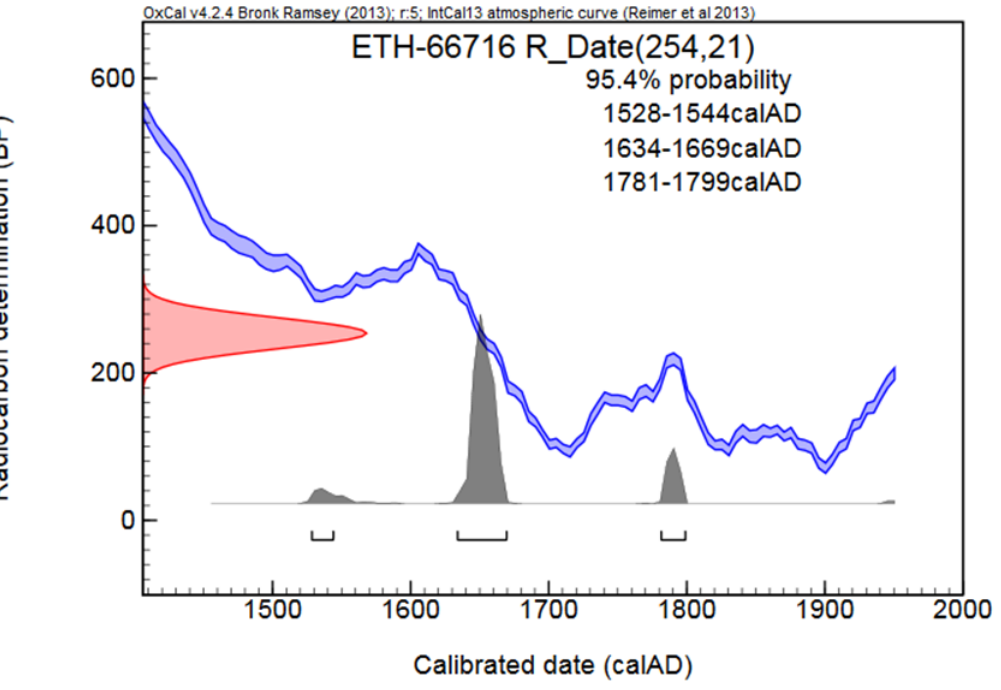
Figure 3. Radiocarbon dating of the Ardea purpurea glacier mummy. 14 C age (BP)—delta C13 corrected radiocarbon age based on concentration of 14 C measured in sample. BP = before present (before 1950 AD) [56,57].